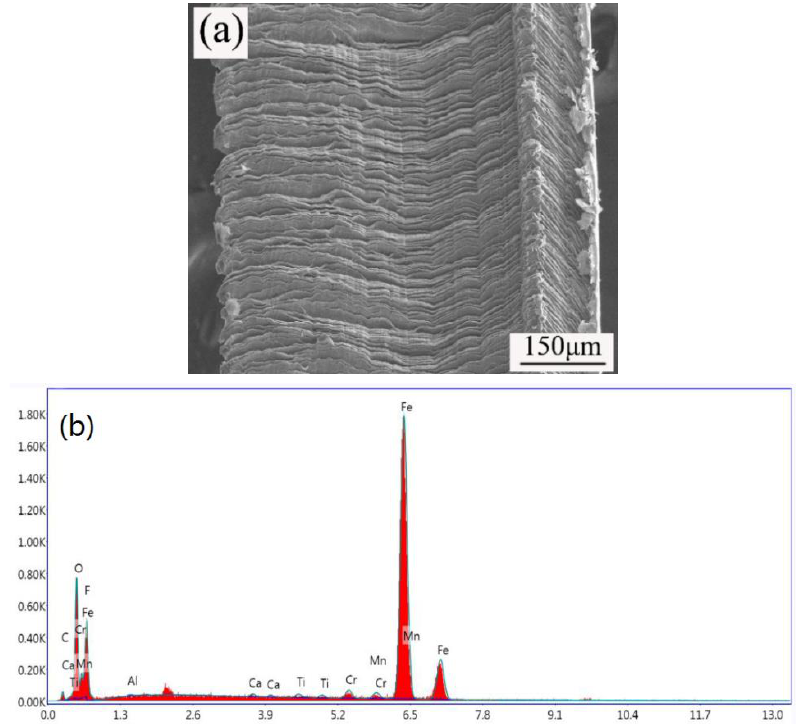
Figure 9. ( a ) Chip morphology and ( b ) energy spectrum analysis of the ATCN-C@10 ceramic tool (test conditions: depth of cut α p = 0.2 mm, feed rates 𝑓 = 0.102 mm/r, υ = 300 m/min).